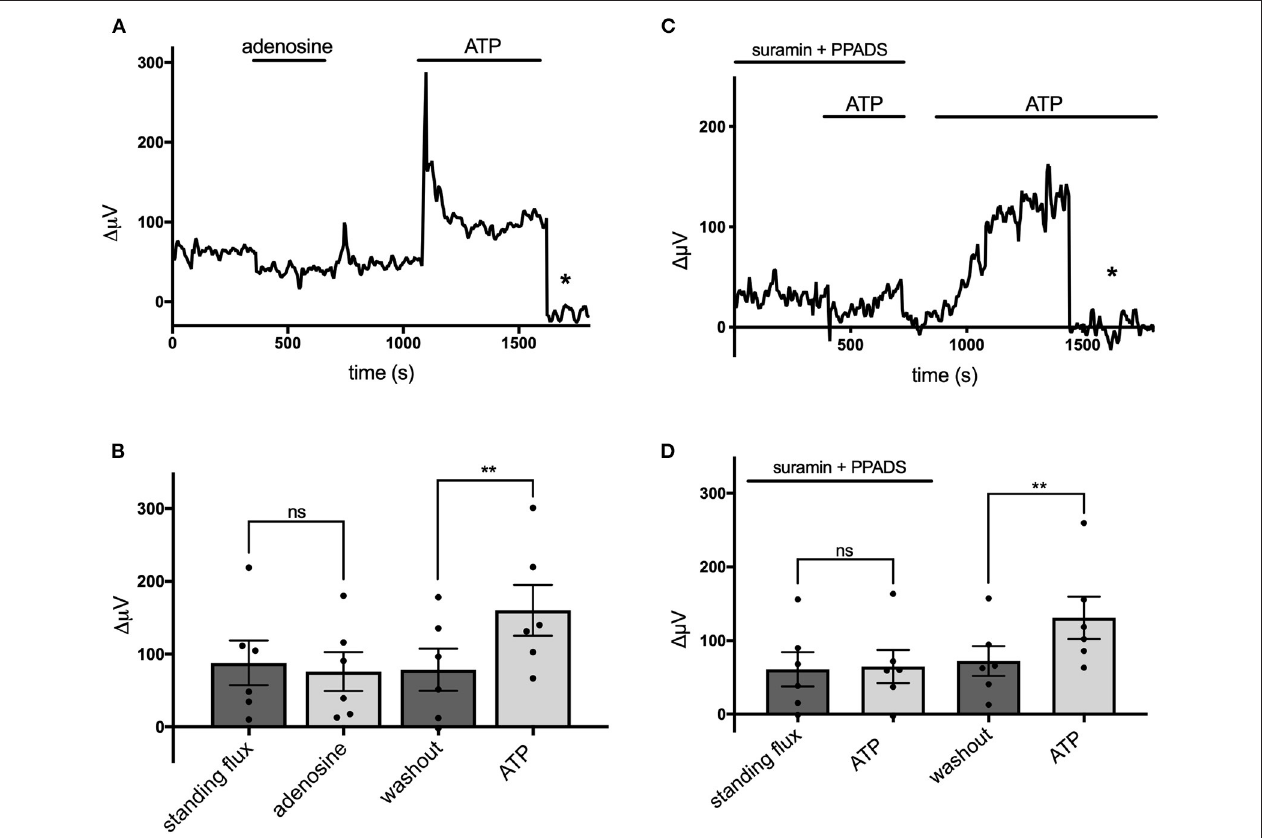
FIGURE 5 | Adenosine does not alter H + flux signals while suramin and PPADS reduce H + flux. (A) Response of a single cell cultured from mouse hippocampus to 100 µ M adenosine and 100 µ M ATP. Asterisk indicates signal obtained when the H + -selective electrode had been moved to a control position 600 µ m above the cell. (B) Quantitative results to the applications of 100 µ M adenosine and 100 µ M ATP from cells ( N = 6). (C) Response of a single cell to 100 µ M ATP first in the presence of 500 µ M suramin and 500 µ M PPADS and then again to 100 µ M ATP following removal of suramin and PPADS. Asterisk again indicates recordings of the H + -selective electrode when at a control position 600 µ m above the cell. (D) Quantitative results averaged from cells to 100 µ M ATP in the presence of 500 µ M suramin and 500 µ M PPADS and response to 100 µ M ATP following removal of suramin and PPADS; N = 6. **indicates P < 0.01; ns indicates not significantly different ( P >